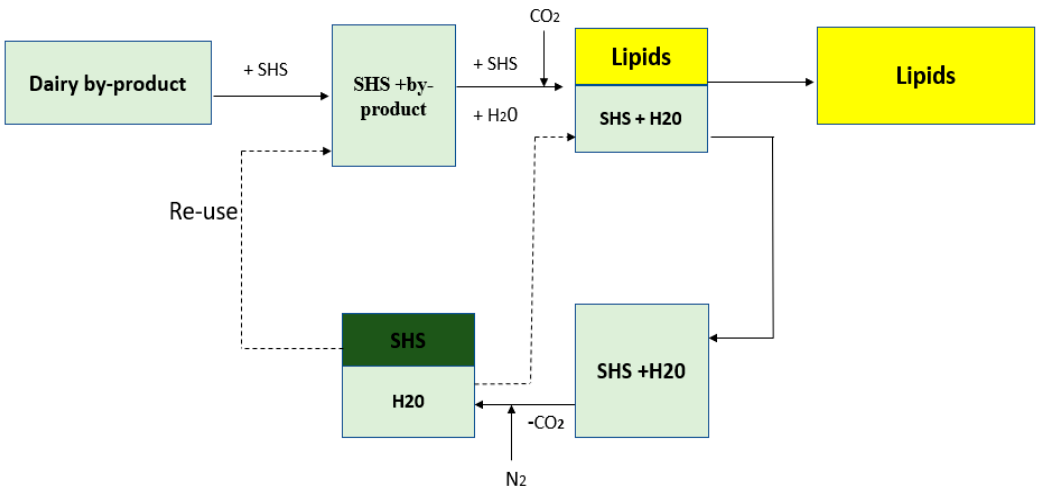
Figure 1. Schematic diagram for the extraction of lipids from dairy byproducts using switchable hydrophilicity solvent (SHS). The dotted lines represent water and SHS that can be reused at the end of the process.